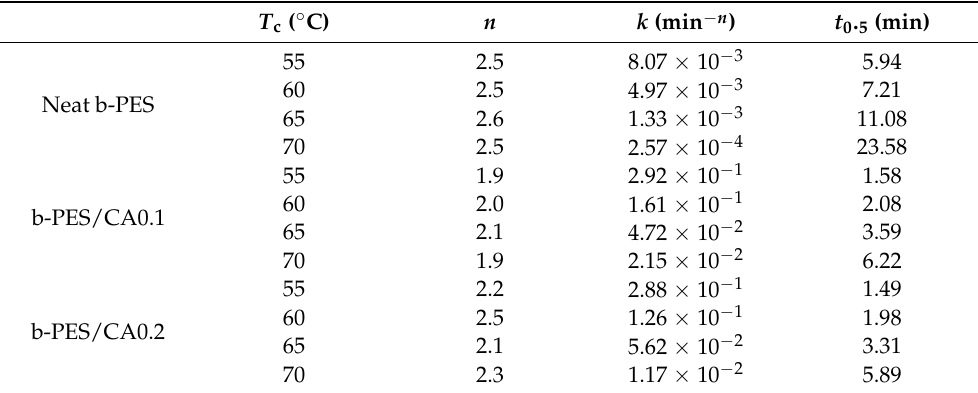
Table 2. Summary of the Avrami parameters of neat and nucleated b-PES during the isothermal melt crystallization.